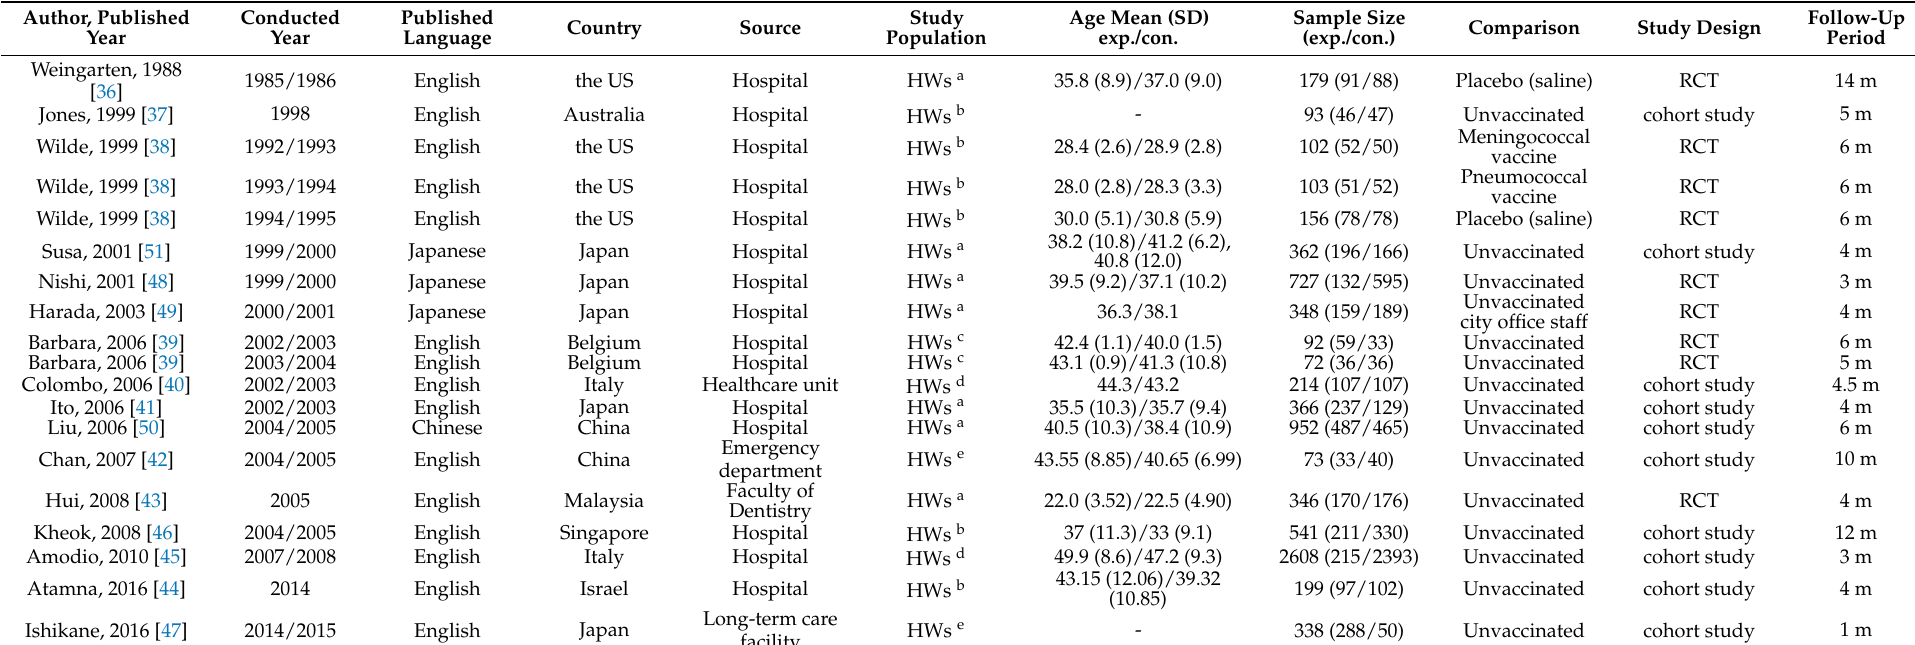
Table 1. Detailed information of included studies in the